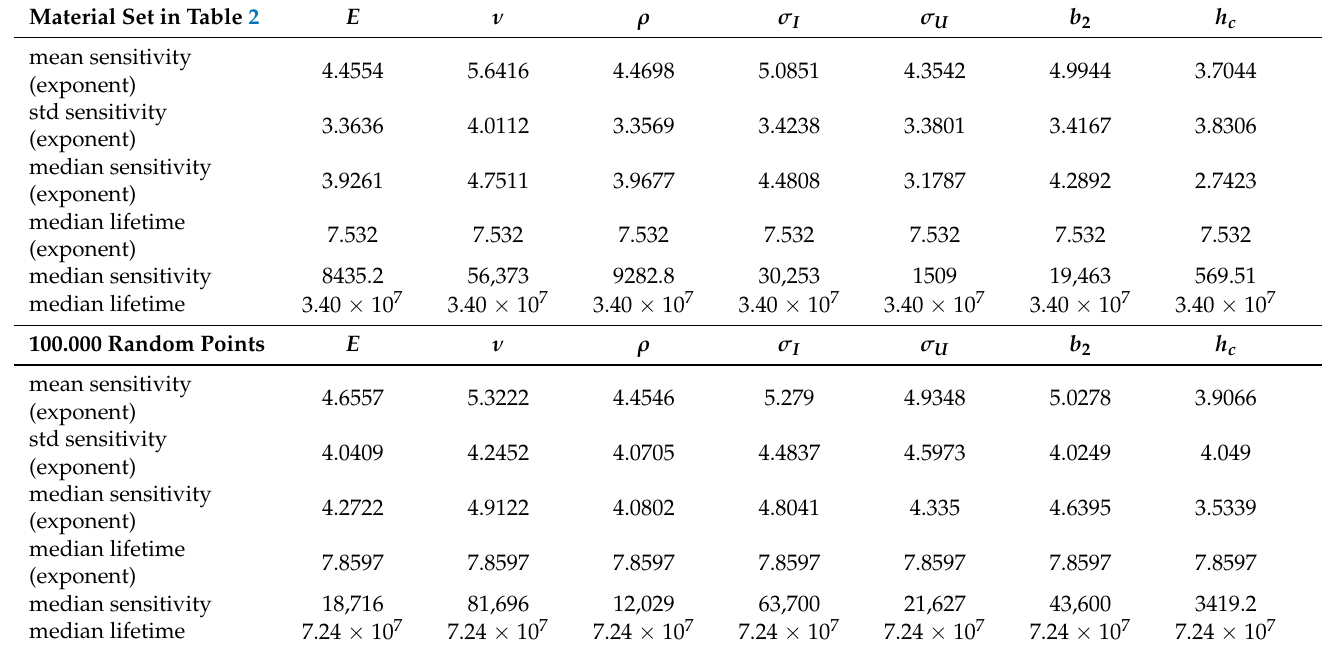
Table 3. Average sensitivity for the global sensitivity